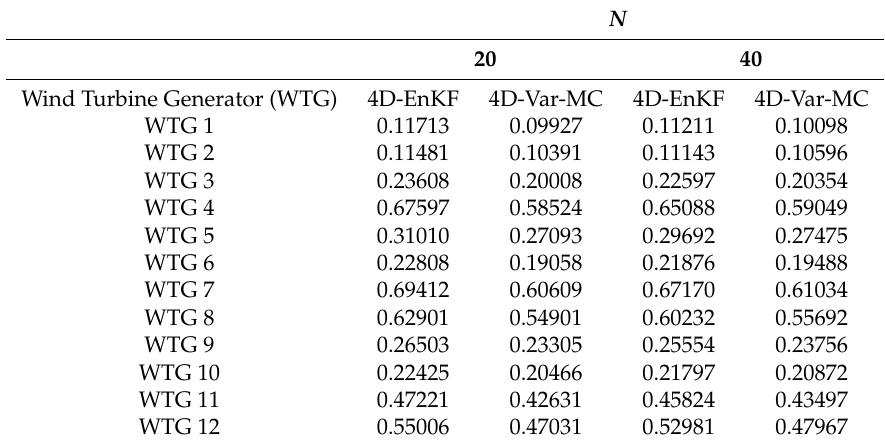
Table 3. Root-Mean-Square-Error values of wind energy potential estimations. Two ensemble sizes are tried during the